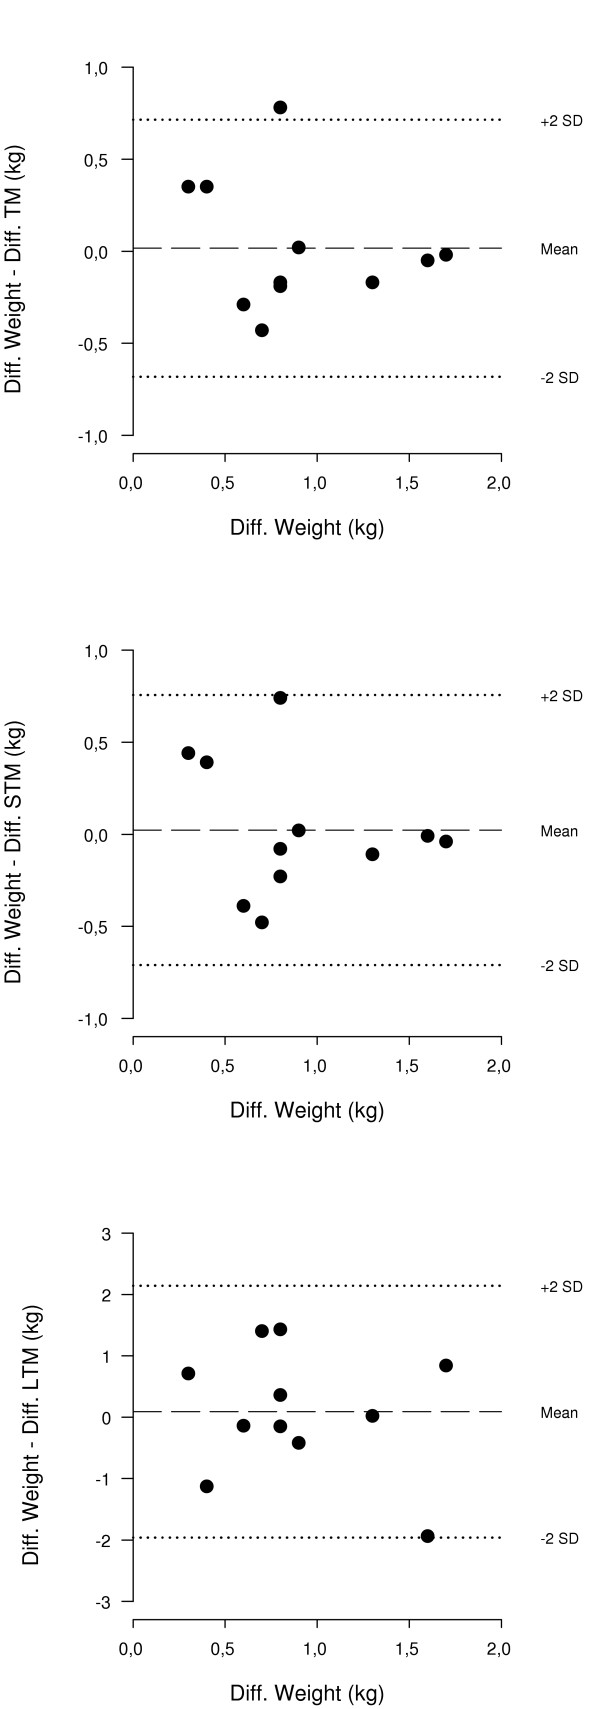
The figure displays the limits of agreement plots of the comparison of change in BW and changes in TM, STM and LTM by DXA following intravenous infusion of parenteral nutrition in 11 patients with short bowel syndrome.